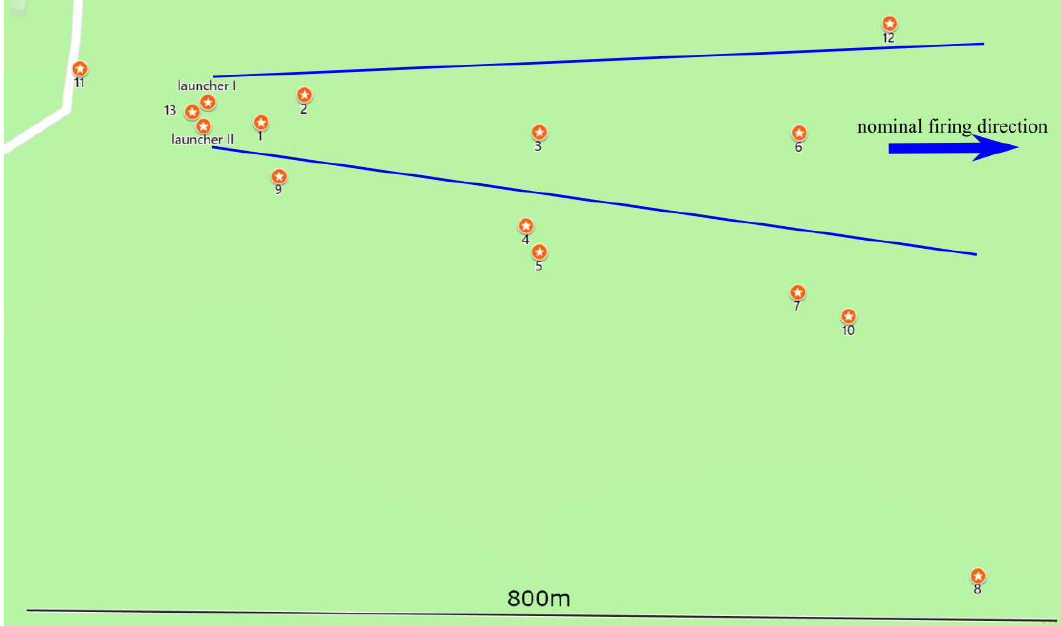
Figure 28. The impact point locations (north direction at the top of the map).